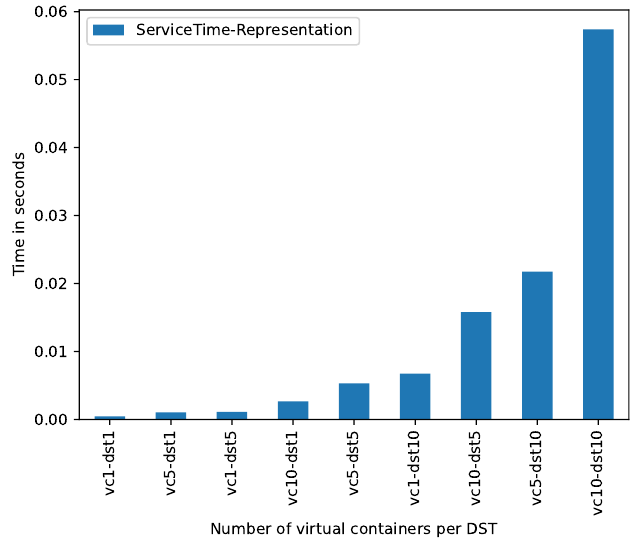
Figure 6. Service time produced by representation component.